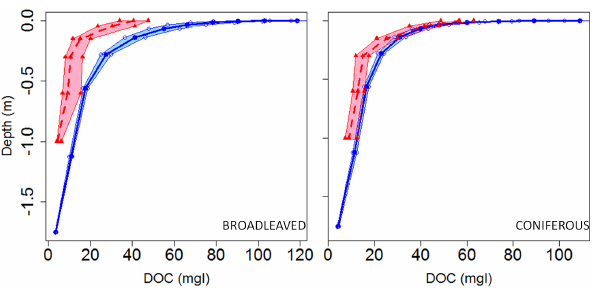
Figure 6. Modeled (blue) versus observed (red dashed) DOC con- centration profiles averaged over the soils of the European conifer- ous and broadleaved forest biome. Data are from Camino-Serrano et al. (2014). The shaded area represents the 95% bootstrap confi- dence interval for model and